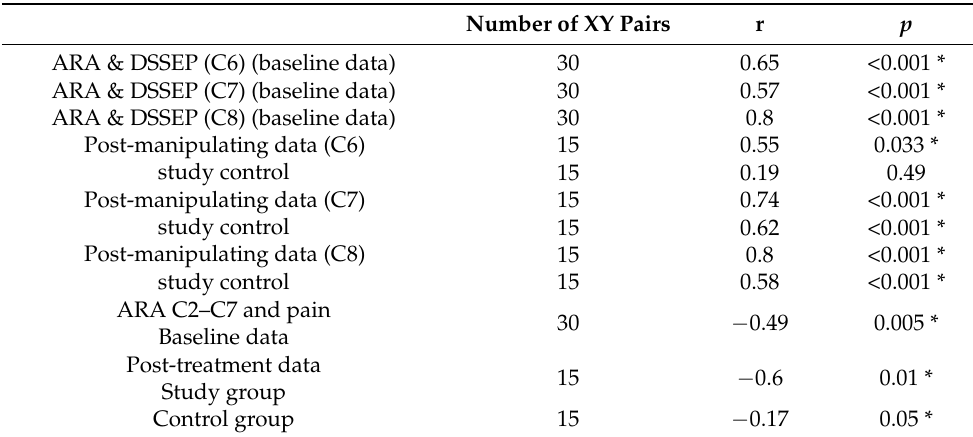
Table 4. Pearson correlation between ARA C2–C7 and DSSEPS and between ARA and pain. Post- manipulating (post-treatment) data are shown for the 2-year follow-up compared to initial base- line data.